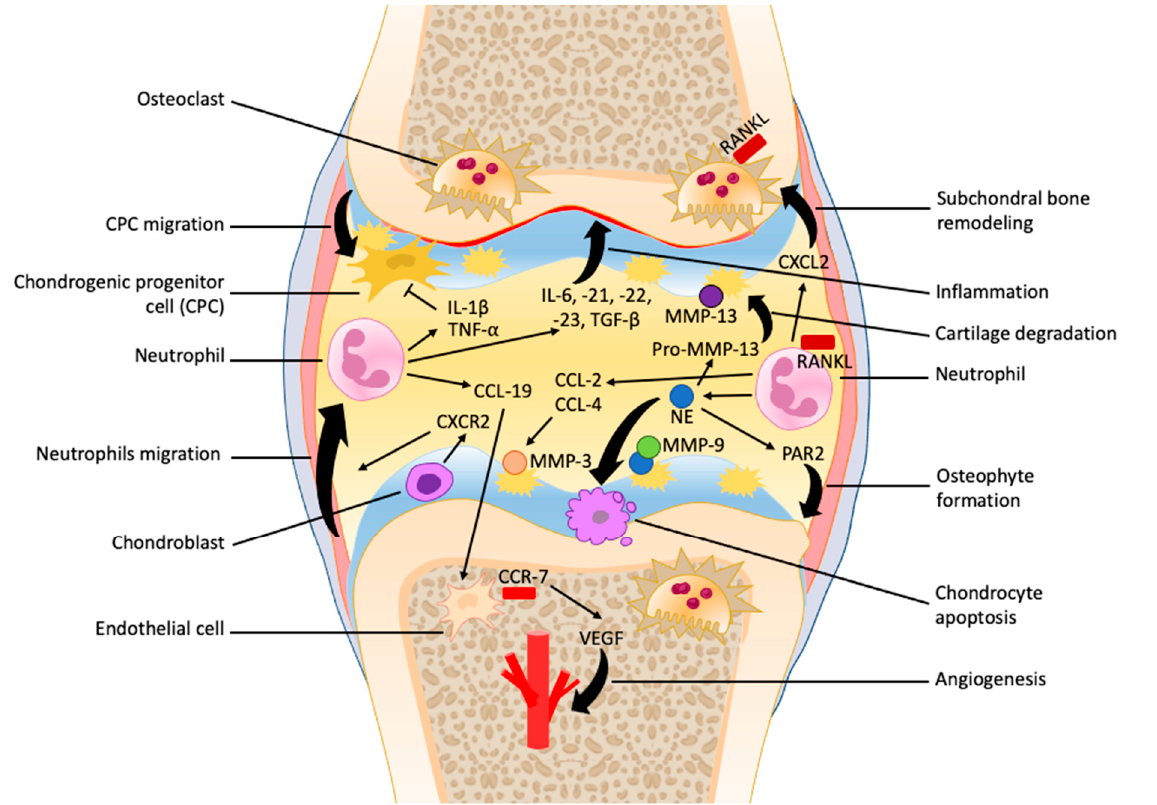
Figure 1. The role of neutrophils in the early as well as late stages of osteoarthritis progression. Neutrophils are recruited at the synovial capsule and contribute to the secretion of many cytokines and chemokines within synovial fluid that promote inflammation and vascular infiltration and inhibit chondrogenic progenitor cell migration. The formation of neutrophil elastase (NE) enhances cartilage degradation, chondrocytes apoptosis, unbalanced subchondral bone remodeling, and osteophyte formation.